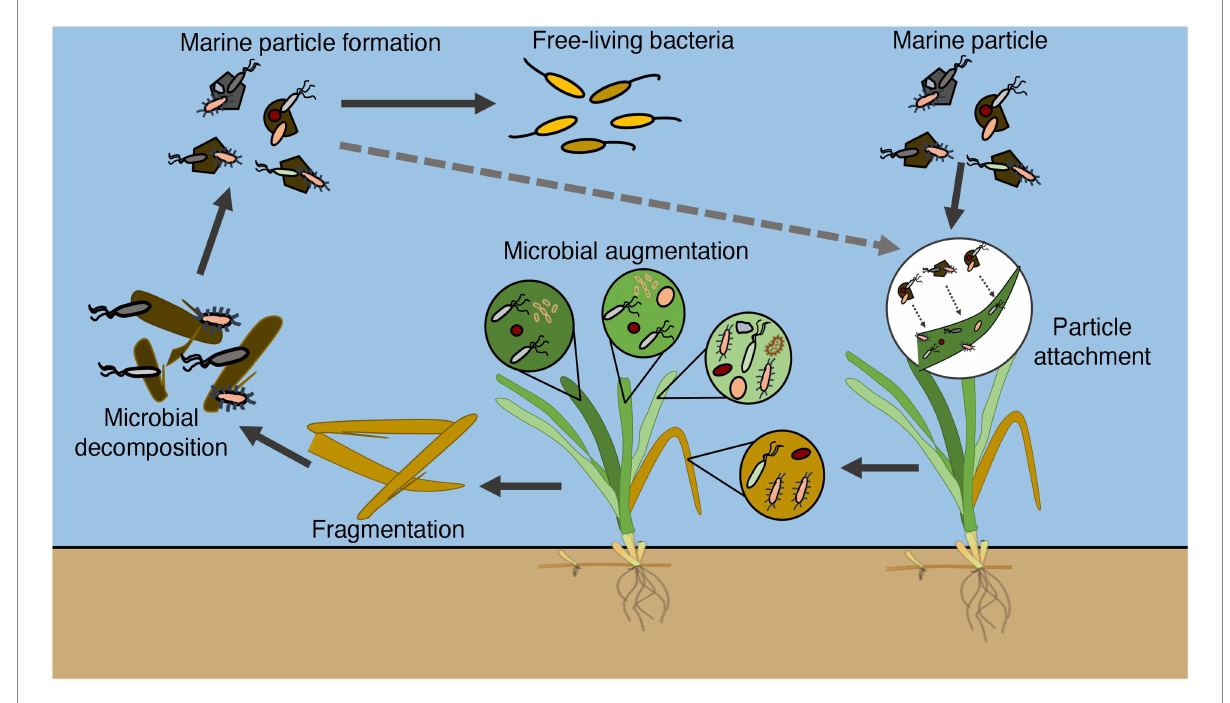
FIGURE 5 Conceptual diagram illustrating how marine bacteria are involved in the growth and decomposition process of eelgrass in Tokyo